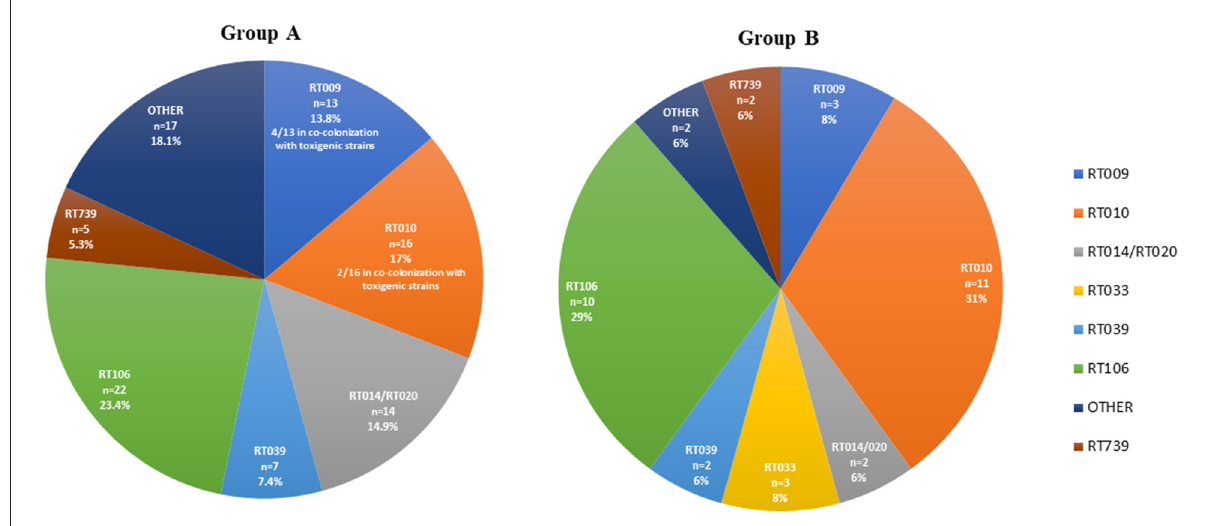
FIGURE1 Ribotype diversity of Clostridioides difficile strains isolated from companion animals in group A (veterinary hospitals, n = 94) and group B (veterinary diagnostic laboratory, n = 35). Other = all other ribotypes with prevalence <